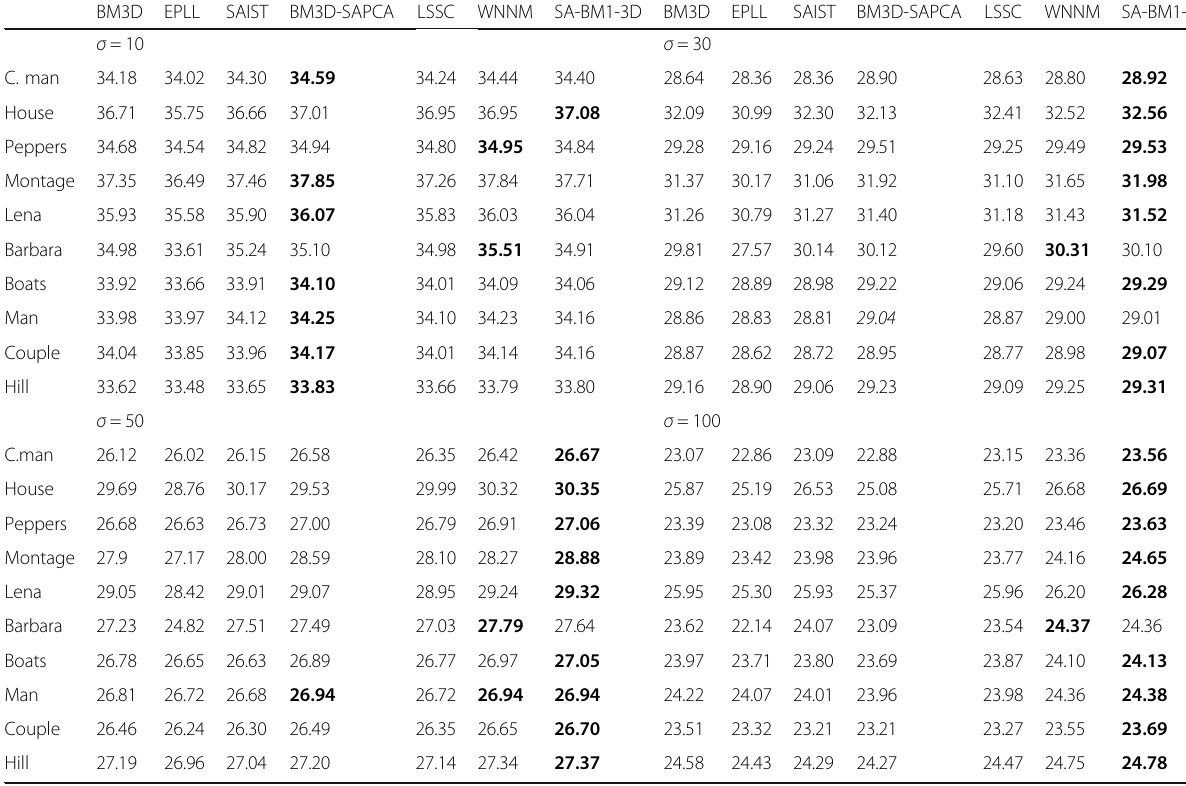
Table 2 Comparison of PSNR values obtained by BM3D, BM3D-SAPCA, EPLL in [8], SAIST in [29], LSSC in [34], WNNM in [35], and proposed SA-BM1-3D BM3D